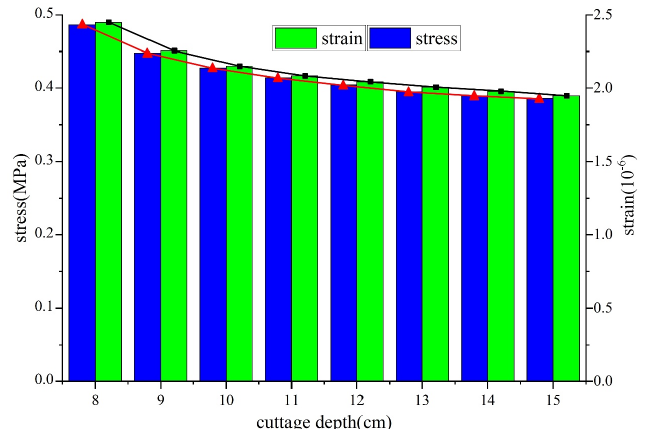
. Under these parameters, the